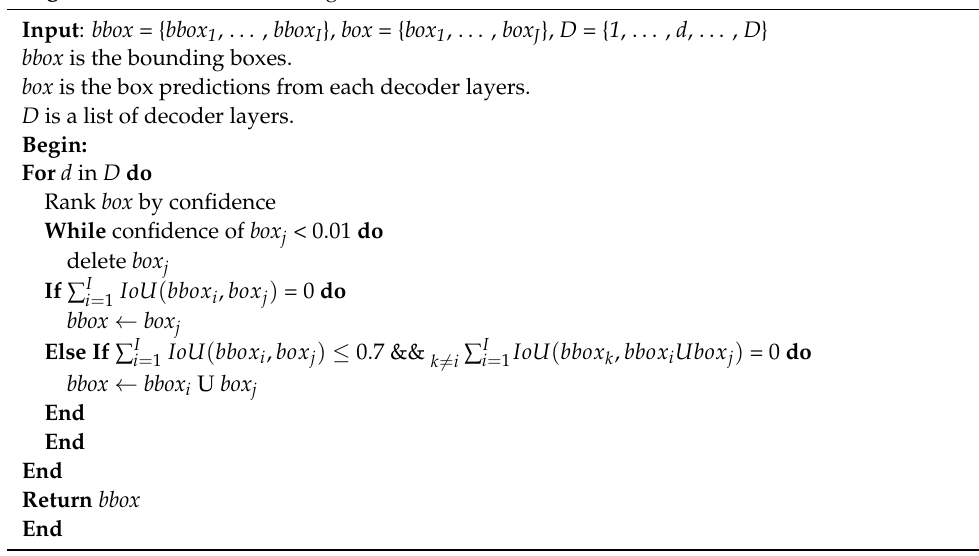
Algorithm 1 Iterative Bounding Box Combination